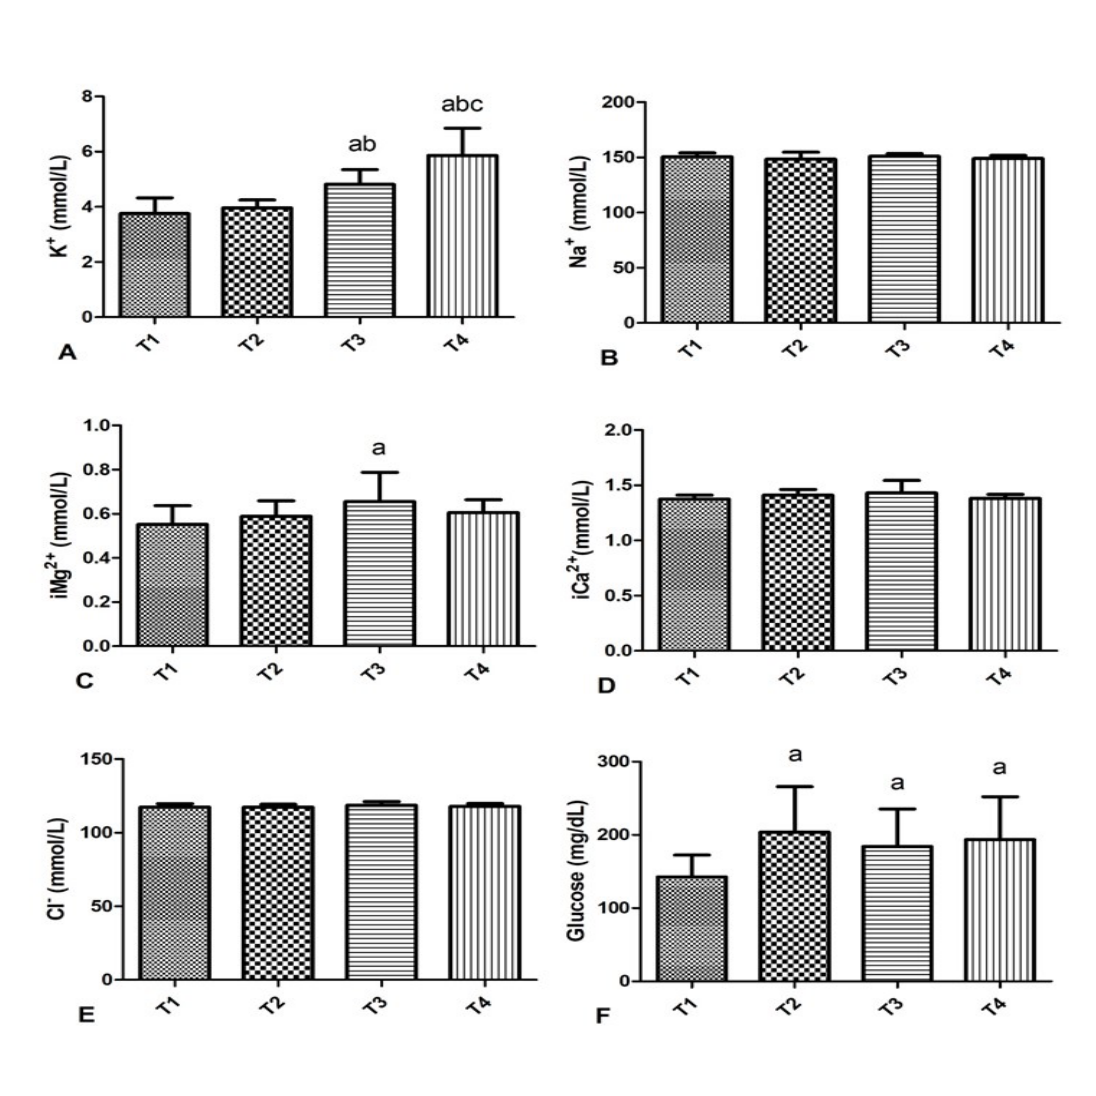
Figure 1. Effect of laparoscopic ovariectomy on blood electrolytes and glucose level. A – Potassium evolution, B – So- dium evolution, C – Ionised magnesium evolution, D – Ionised calcium evolution, E – Chloride evolution, F – Glucose evolution. (mean ± SD) (n = 9) (a = p<0.05 as compared to T1) (T1= Pre-induction, T2= control, T3= 30 min of pneumoperi- toneum, T4= the end of